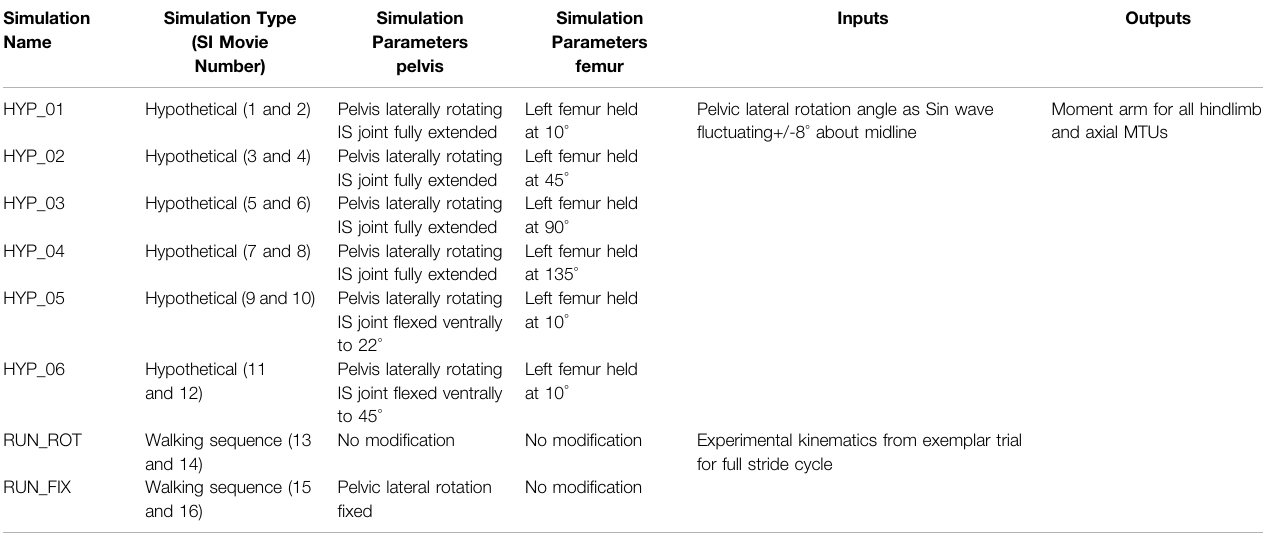
TABLE 2 | List of simulation parameters, input data, and output data for all hypothetical and walking sequence simulations run in this study. MTU (muscle tendon unit), IS (Iliosacral